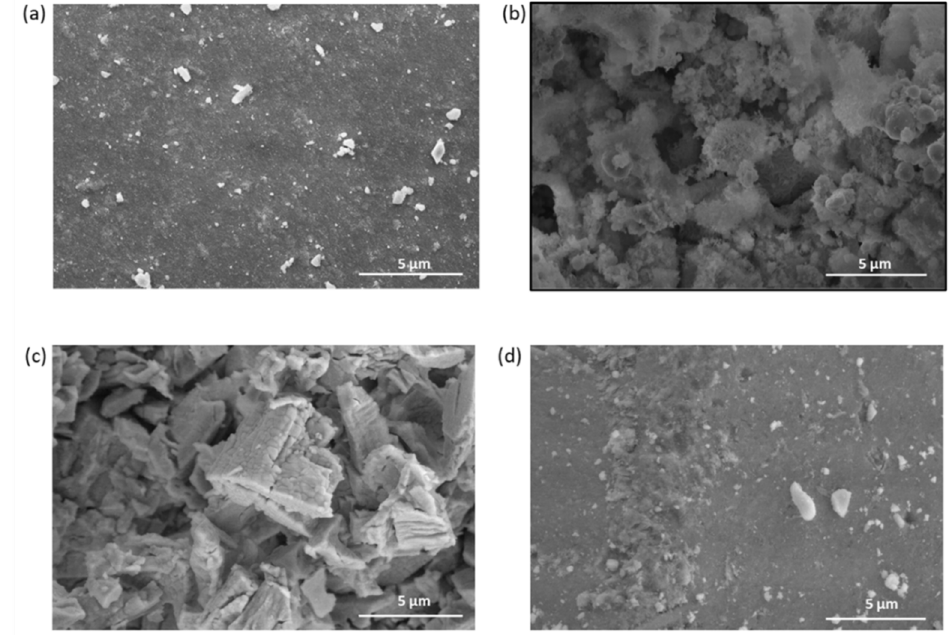
Figure 1. SEM images of ceria and ceria–zirconia: ( a ) ceria obtained via precipitation, ( b ) ceria obtained via thermal decomposition, ( c ) commercial ceria and ( d ) ceria–zirconia at a magnification of 20,000 times.